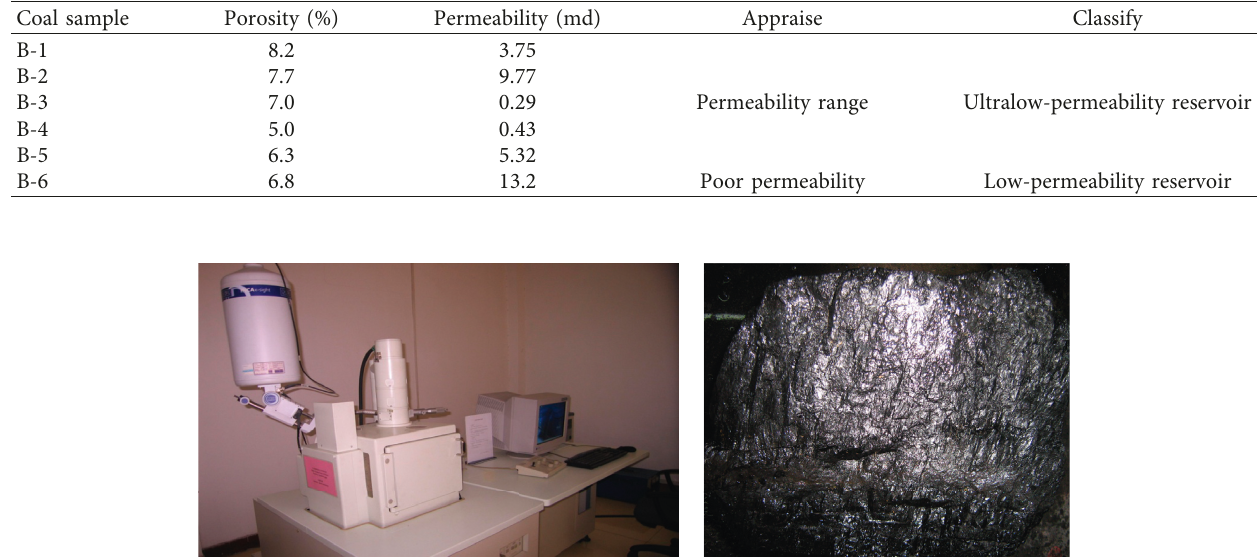
Table 1: Permeability of different coal samples.